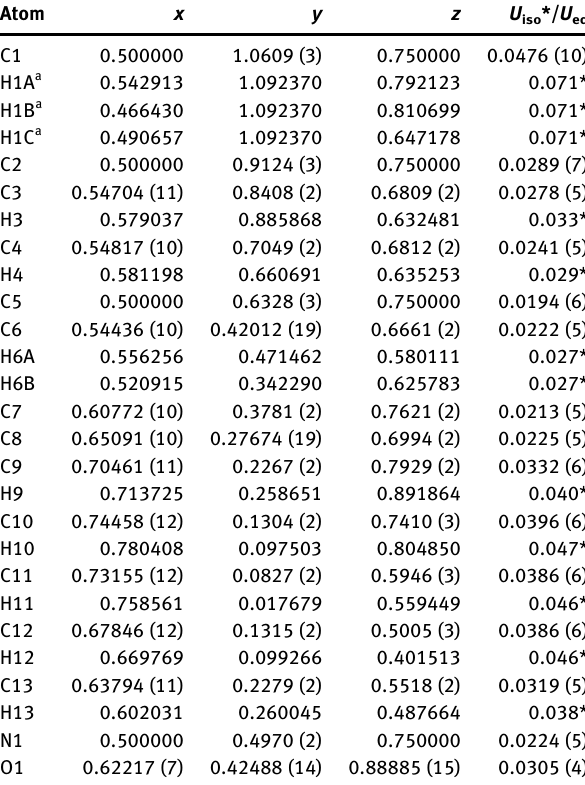
Table  : Fractional atomic coordinates and isotropic or equivalent isotropic displacement parameters (Å 